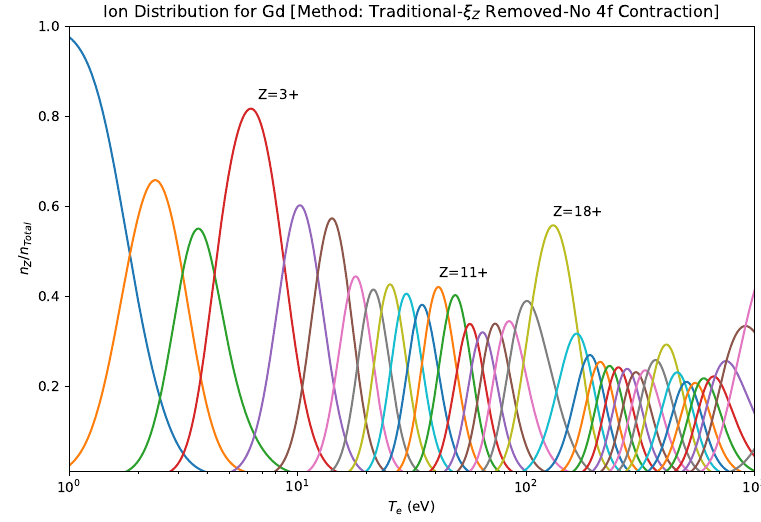
Figure 6. A Gd ion distribution generated using the traditional CR model by Colombant and Tonon using the NIST χ s, with no ξ term, and without the 1 correction. Since the ξ was removed, whether 3 Z Z Z or not 4 f contraction is taken into account produces the same distribution. Here ion stages are denoted by the different colored curves, and the 3 + , 11 + , and 18 + stages are marked, due to the observed ionization